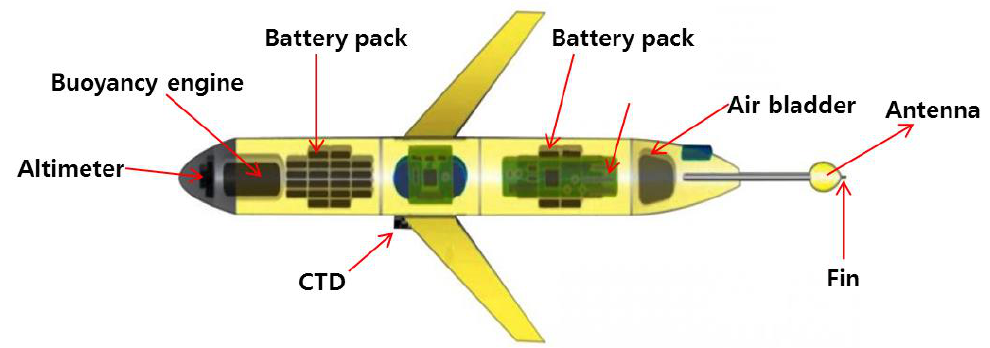
Figure 1. Components of the Slocum Underwater Glider.